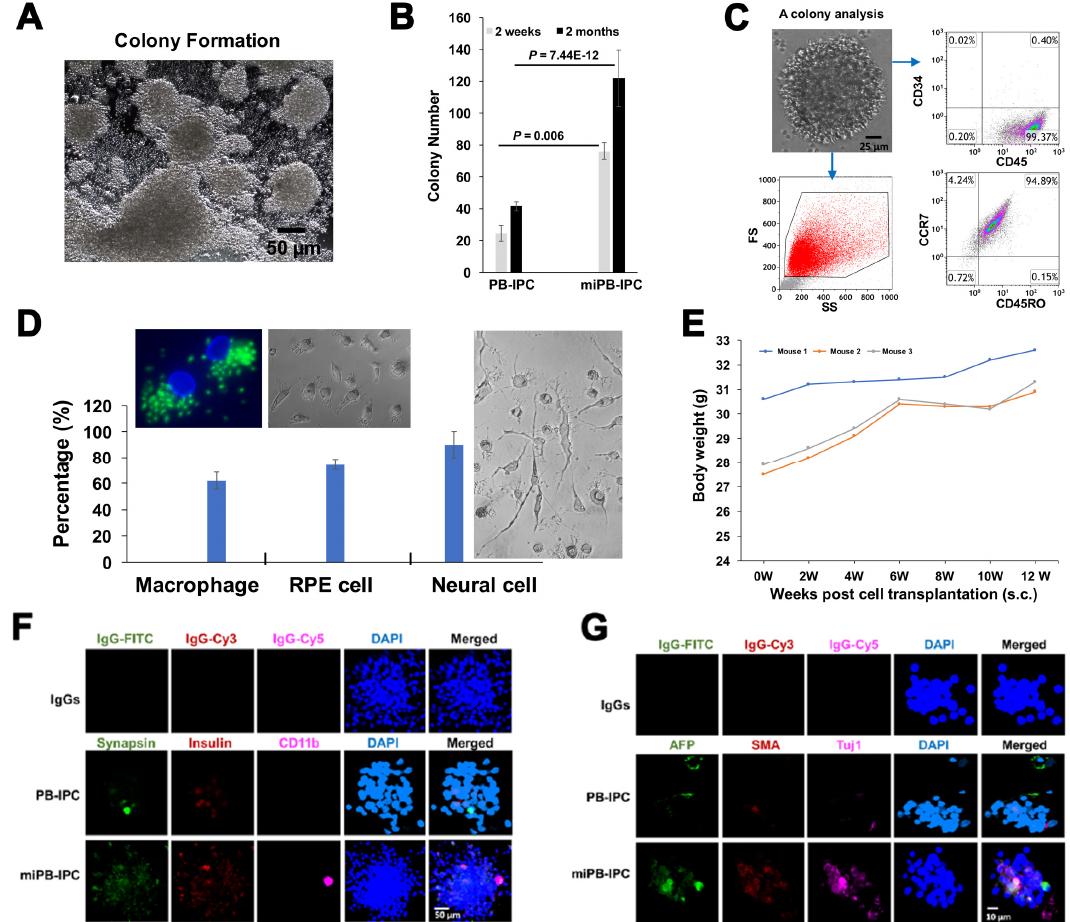
Figure 4. Clonal analysis of miPB-IPC and testing for tumor formation of miPB-IPC. ( A ) Colony formation of miPB-IPC with different sizes in regular miPB-IPC cell cultures ( n = 5). ( B ) Potential difference in colony formation between miPB-IPC relative to untreated PB-IPC. Increase the colony formation in miPB-IPC relative to untreated PB-IPC. The colony formation of miPB-IPC with different sizes at 2-month culture in 24-well plate. The miPB-IPC were initially cultured with the serum-free NutriStem ® hPSC XF culture medium (Corning) at 1 × 10 4 cells/mL/well in 24-well tissue culture plates, at 37 °C in 8% CO 2 culture condition. Data are presented as mean ± SD from five preparations. ( C ) Phenotypic analysis of single colony-derived cells, retaining the PB-IPC’s markers CD34 - CD45 + SOX2 + CD45RO + CCR7 + ( n = 5). ( D ) Clonal analysis. A single colony was dispersed and inoculated into 96-well plates, treated wells with different lineage-specific inducers for differentiations, including macrophages (left, phagocytosis of green fluorescence beads, n = 3), RPE cells (middle, n = 6), and neural cells (right, n = 9). ( E ) Gaining weight in miPB-IPC-transplanted mice, without tumor formation. The miPB-IPC at the dose of 2 × 10 7 cells/mouse were inoculated (s.c., right lower flank) in NOD-scid IL-2R γ null mice ( n = 3). Injection of equal volume of physiological saline on the left lower flank served as control. ( F ) Colony analysis with three-germ layer-associated markers such as a neuronal marker synapsin I for ectoderm, the islet β cell marker insulin for endoderm, and a macrophage marker CD11b for mesoderm. IgGs served as negative controls (top panel). Representative images were from one of eight colonies for miPB-IPC group (bottom panel) and five colonies for control PB-IPC (middle panel). ( G ) Colony analysis with additional three-germ layer-associated markers such as a neuronal marker beta III tubulin (Tuj1) for ectoderm, the liver cell marker alpha-fetoprotein (AFP) for endoderm, and smooth muscle actin (SMA) for mesoderm. IgGs served as negative controls (top panel). Representative images were from one of seven colonies for miPB-IPC group (bottom panel) and five colonies for control PB-IPC (middle panel).